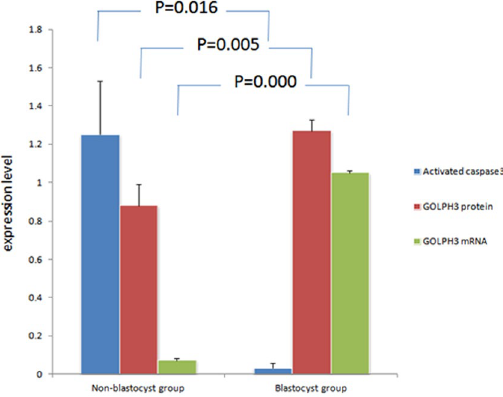
Figure 6. Comparison of cumulus granulosa cell apoptosis and GOLPH3 expression in cumulus granulosa cells between the non-blastocyst and blastocyst